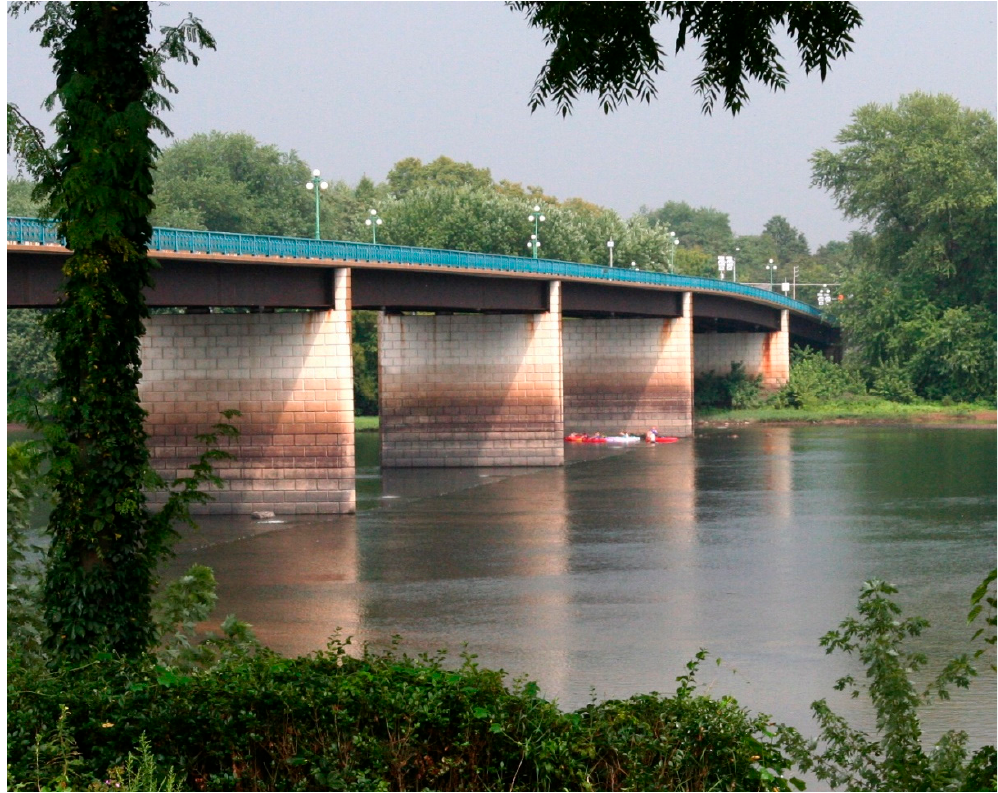
Figure 5. A colorful flotilla of kayakers on the West Branch retreating from a summer shower under the Market St. bridge at Lewisburg; kayaking has become the dominant use of the surface of the waterway in recent